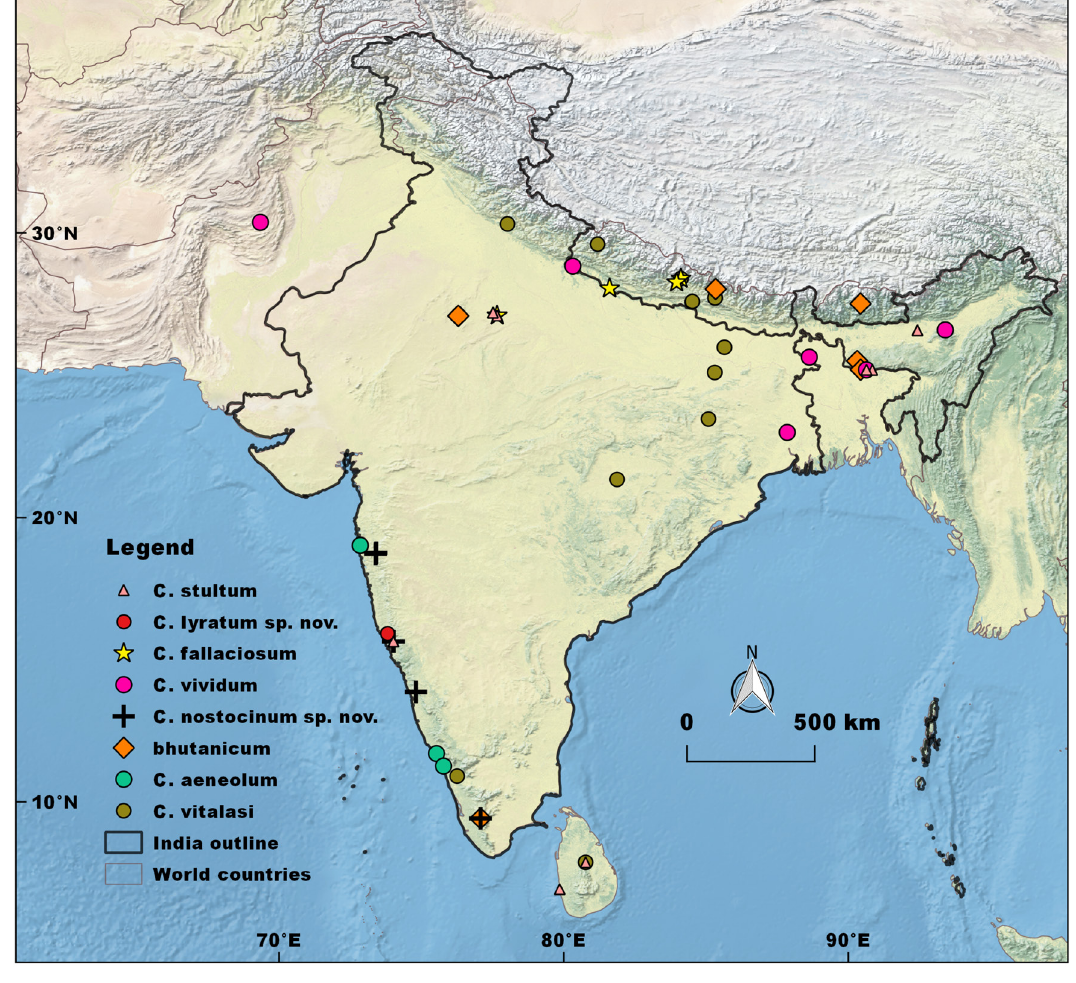
Fig. 11. Known distribution of the Coelostoma s. str. and Holocoelostoma species in the Indian